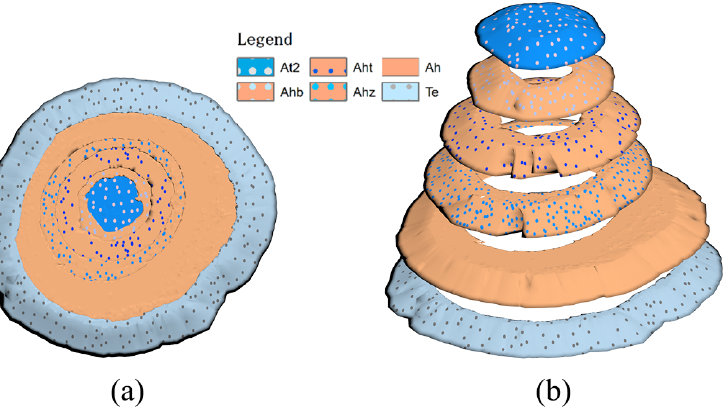
Figure 16. The model of Richard structure: ( a ) Top view of Wulongshan dome strata; ( b ) scattered view of Wulongshan dome strata.